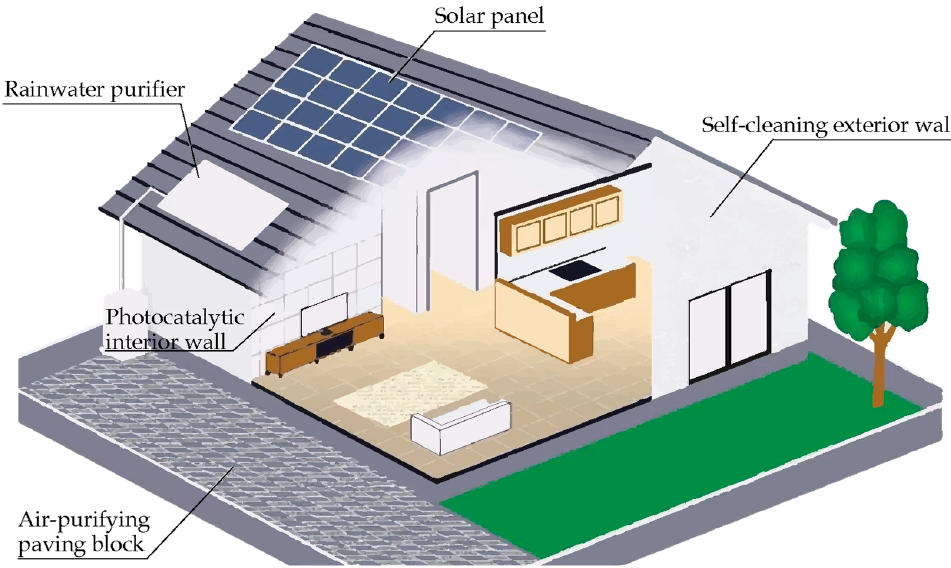
Figure 1. TiO 2 -based application for eco-efficient building.